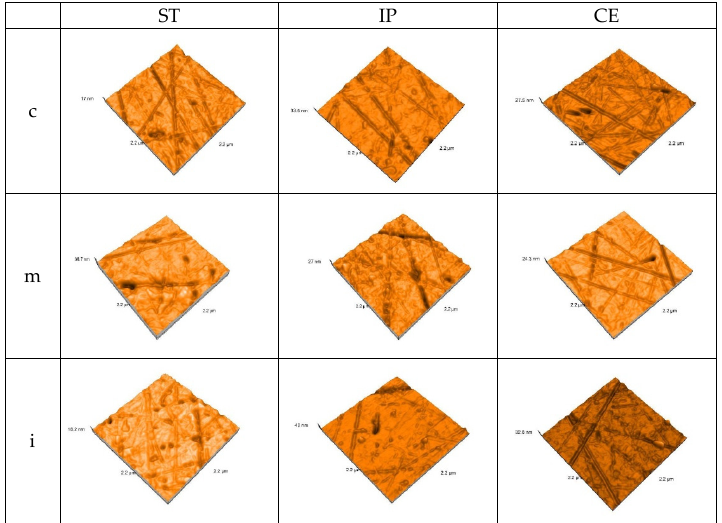
Figure 3. 3D AFM images of the glazed samples, before aging.ST = STML, IP = IPS e.maxZirCAD CEREC/in Lab MT Multi, CE = CeramillZolidfx ML. c = cervical, m = medium, i = incisal. The AFM 3D images on each area of the polished samples of the control group are shown in Figure 4.